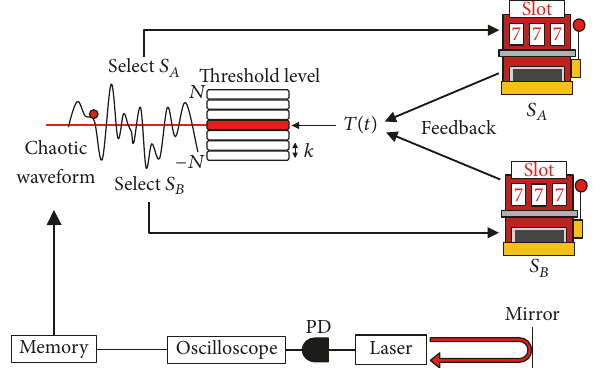
Figure 1: Decision-making system architecture based on the tug-of- war method using chaotic temporal waveforms of the semiconduc- tor laser. PD, photodetector; 𝑆 𝐴 , slot machine 𝐴 ; 𝑆 𝐵 , slot machine 𝐵